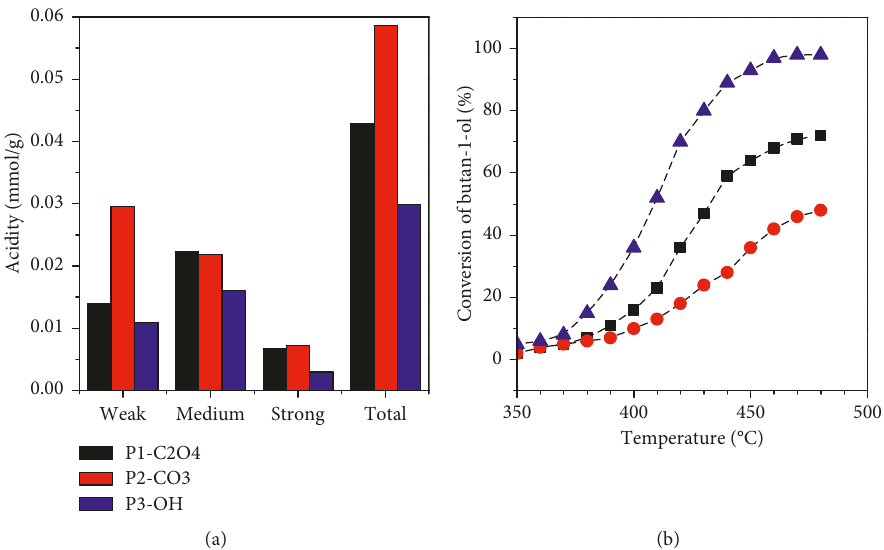
Figure 8: The proportion of the sites of acid character and dependence of butan-1-ol conversion on temperature for the ferrite powders obtained by